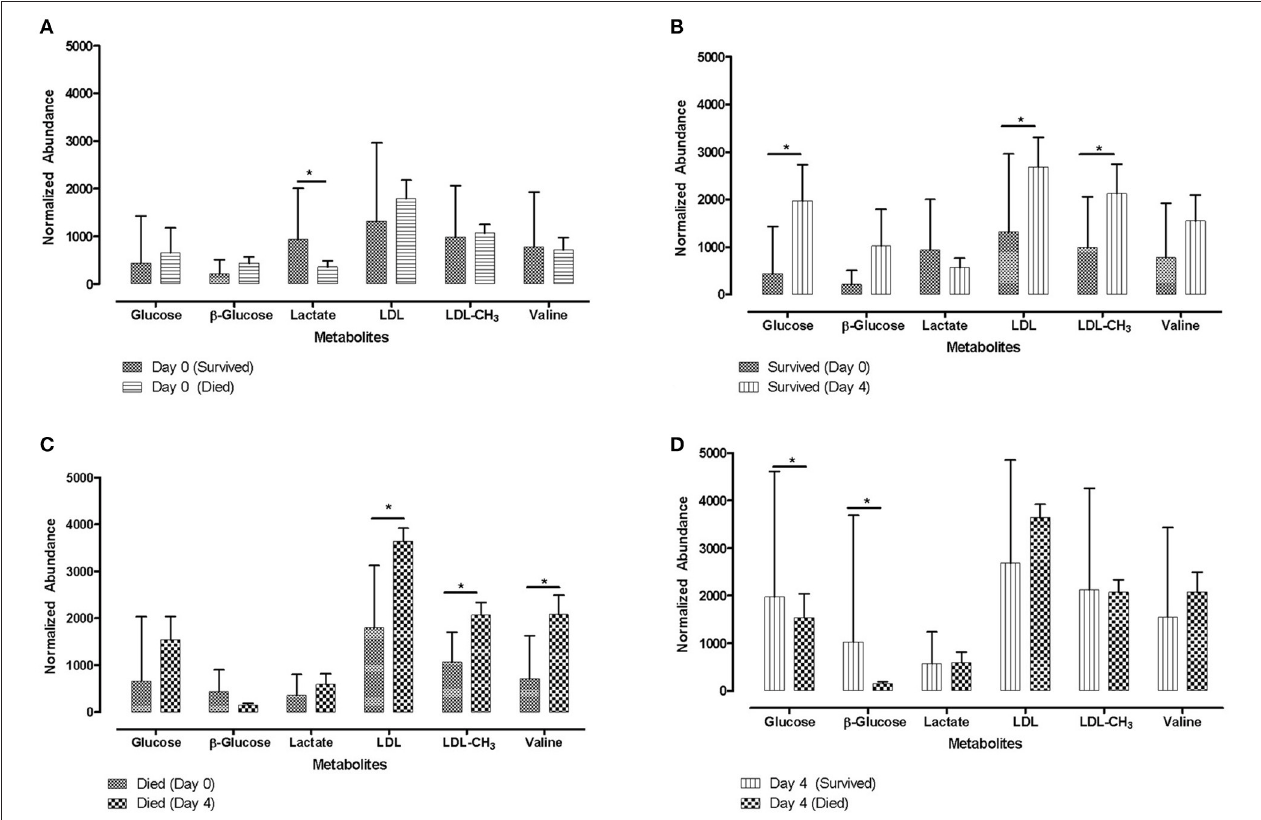
FIGURE 3 | Metabolite profiles for animals that survived or died. Letters (A) to (D) represent four different situations depending on metabolite data derived from samples collected on Day 0 (prior to viral infection) and samples collected on Day 4 (post BHV-1 infection). Bar charts for distribution profile of identified metabolites from 1 H-NMR studies for animals that died or survived following synergic viral-bacterial infection are shown in bar chart form. Error bars shown indicate 1-standard deviation. Metabolite IDs are shown on the x-axis [The publisher for this copyrighted material is Mary Ann Liebert, Inc., publishers Aich et al. (49)]. *Significant differences p <